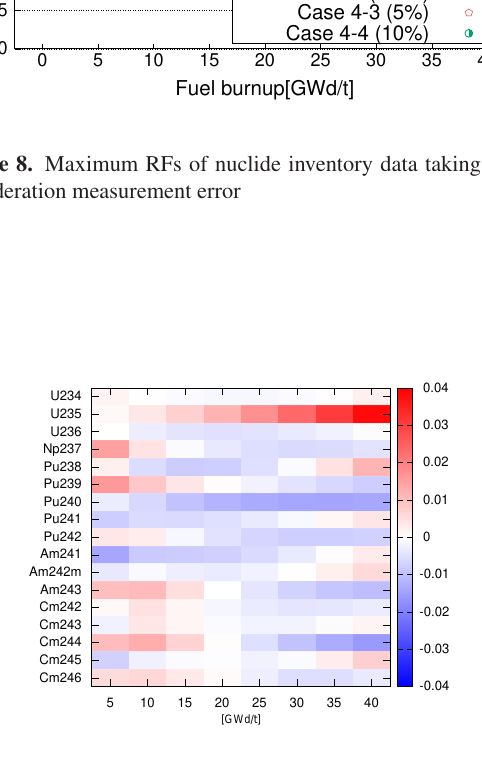
Figure 12. Decomposed sensitivities of fictitious parameters to Figure 9. Weights of individual mockup parameters in the ficti- Pu-241 capture cross section in tious mockup parameters for k at 40 GWd / t (Case 4-2) ∞